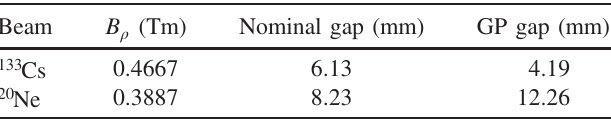
TABLE II. Slit gaps needed to admit (cid:3) 2 σ of the recoils within a (cid:3) 4% dE=E acceptance for the nominal tunes and the final GP